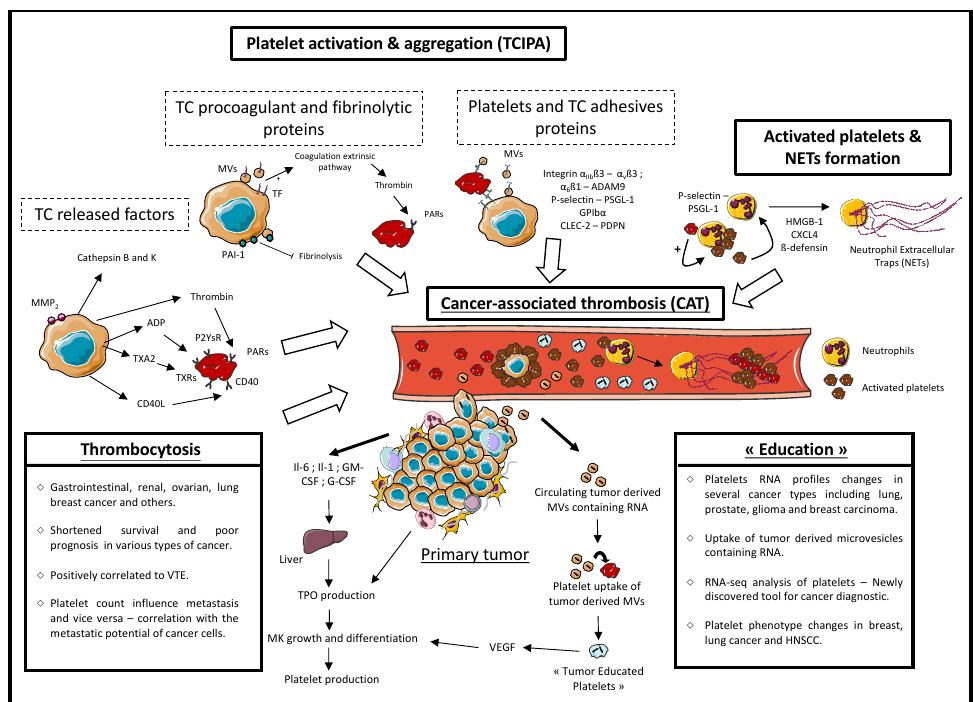
Figure 2. Impacts of cancer on platelet production, activation and education and mechanisms of cancer-associated thrombosis. This figure summarizes all the mechanisms involved in the production, the activation and the education of platelets mediated by the primary tumor and the mechanisms of cancer-associated thrombosis. TC: Tumor Cell. This figure was obtained using Servier medical art.